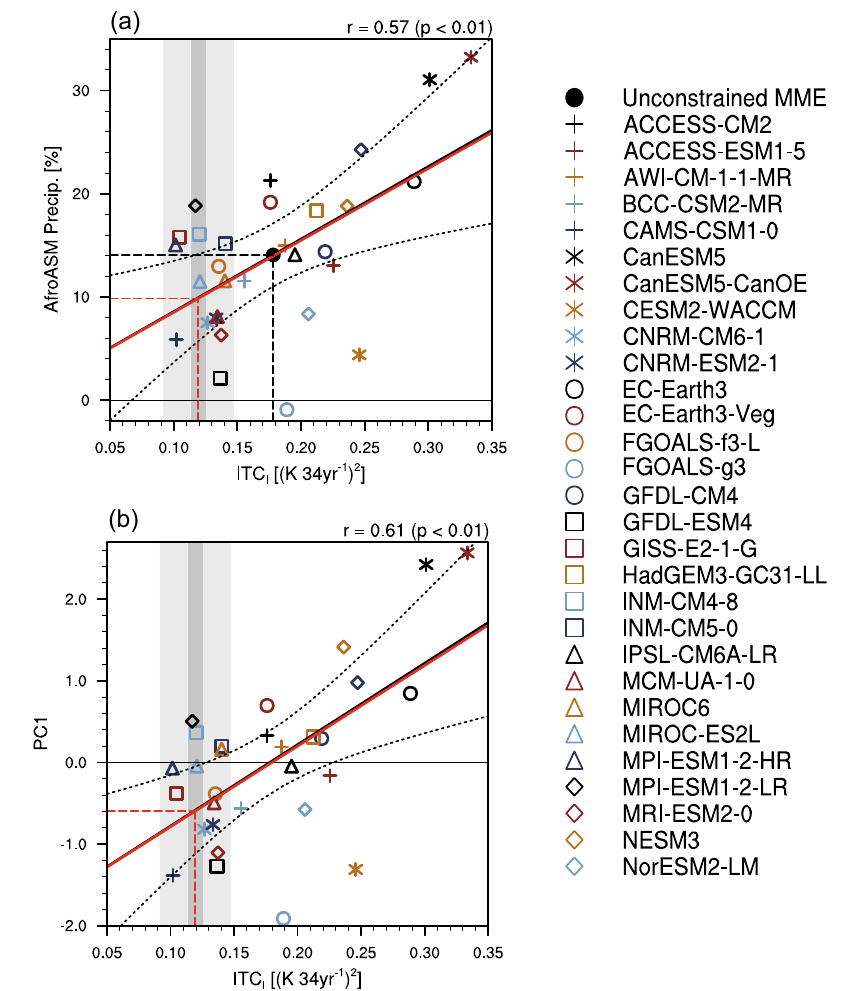
Fig. 4 Relationship between spreads in projection of Afro-Asian summer monsoon (AfroASM) precipitation and historical warming pattern. The scatter diagram between interhemispheric thermal contrast pattern index ( ITC I , (K 34 yr − 1 ) 2 ) across models in the present-day climate and inter-model spread of AfroASM precipitation ( a ) and normalized PC1 ( b ). ITC I can explain the PC1 with high corrected correlation coef fi cient (r) which is shown on the top right corner. Black fi tting line is obtained by the least square method, and the red fi tting line is an observational correction based on Eq. (5) (Eq. (5); see Methods). Dashed curves denote the 95% con fi dence range of the linear regression. The red (black) vertical and horizontal dash lines denote the mean of ITC I across multiple observation datasets (models) and the constrained (raw) projection, respectively. The dark gray shading denotes the range of ±1 σ across observation datasets. The light gray shading denotes the range contributed from the unforced internal variability (see